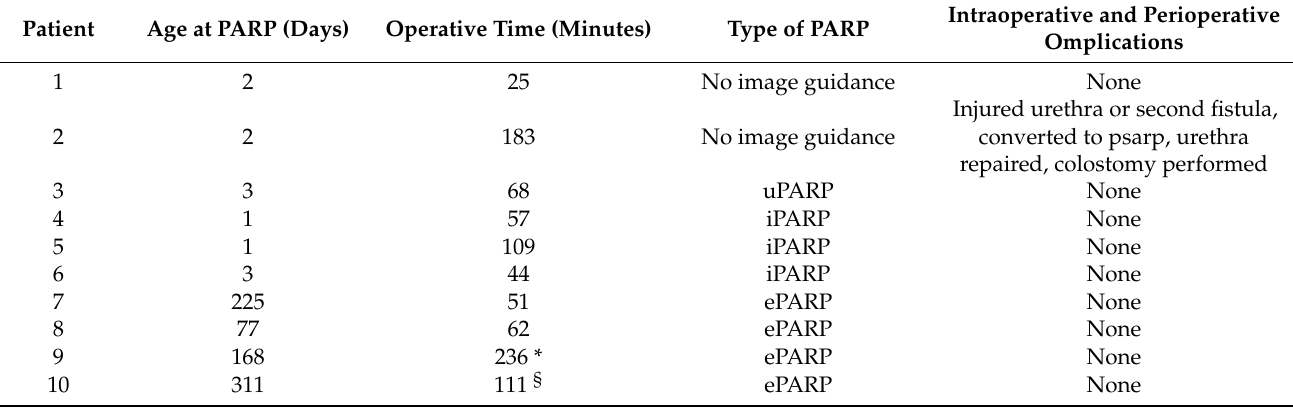
Table 2. Operative data and complications. (* Total operative time includes ePARP and other procedures, namely, cystoscopy, esophagoscopy, Kimura-lengthening of upper esophageal pouch. § Operative time includes cystoscopy).